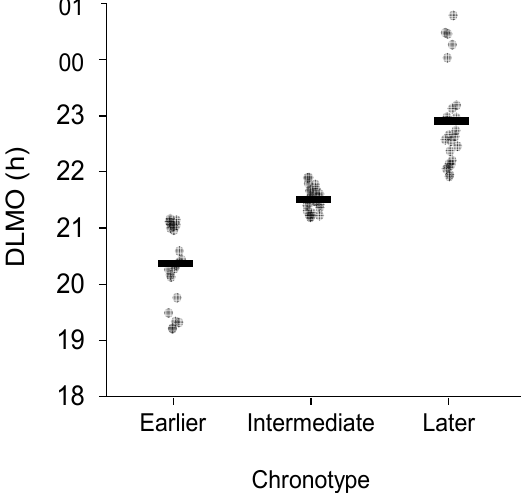
Figure 1. Distribution of DLMO for earlier, intermediate, and later chronotypes. Black bars represent mean DLMO for each chronotype. DLMO times are shown in decimal